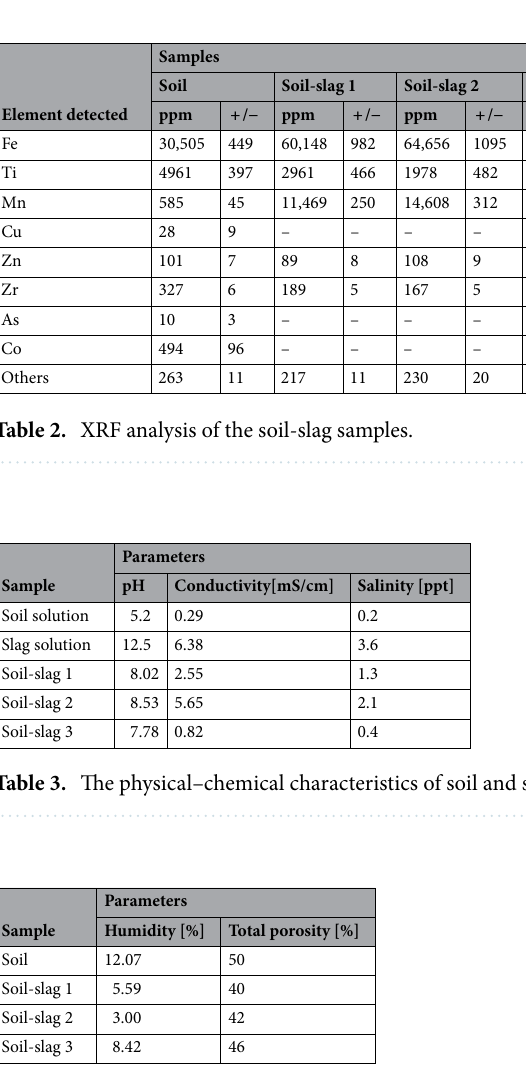
Table 4. The physical–chemical characteristics of soil-slag